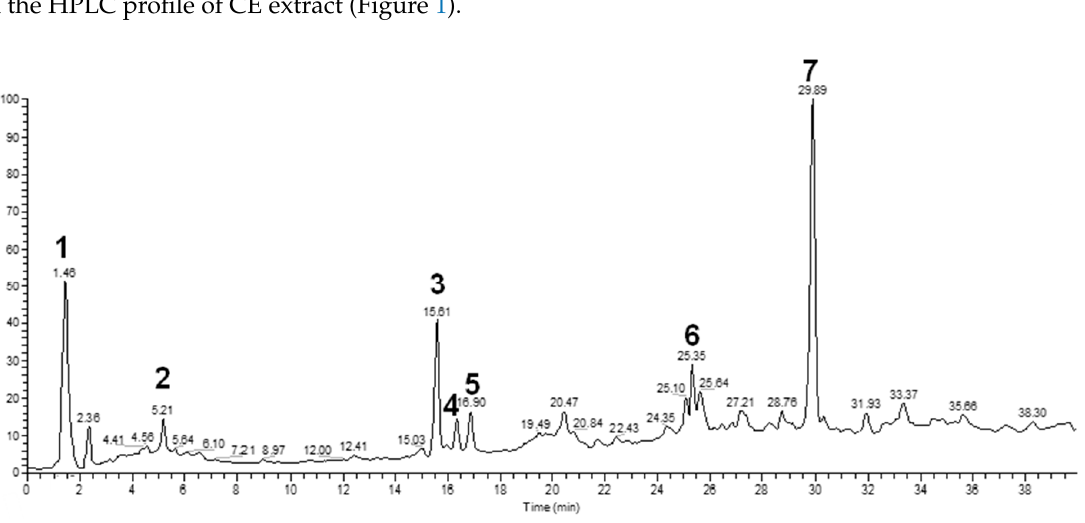
Figure 1. Chemical profile of Calycophyllum spruceanum water extract. Seven major peaks were identified by MS/MS analyses.